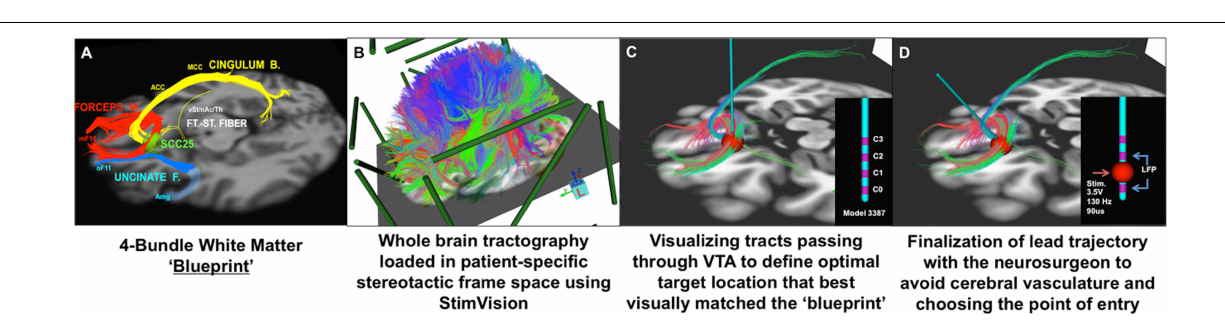
FIGURE 3 | Individualized tractography-guided, template-matching lead implantation procedure for SCC DBS for TRD. (A) 4-bundle tractography target template (Riva-Posse et al., 2014). (B) Overlap of whole-brain deterministic tractography in patient-specific stereotactic frame space using the “StimVision” toolbox (Noecker et al., 2018). (C) Initial placement of electrode within SCC and visualization of WM pathways passing through the VTA. (D) Personalized optimal electrode location with the arc and ring angle determination by a neurosurgeon. Estimated VTA with standard stimulation settings (i.e., 3.5V, 130Hz, 90ms) is visualized with local field potential recording from adjacent contacts (sandwiching recording to minimize stimulation artifact). Composite images courtesy of Ki Sueng Choi, Icahn School of Medicine at Mount